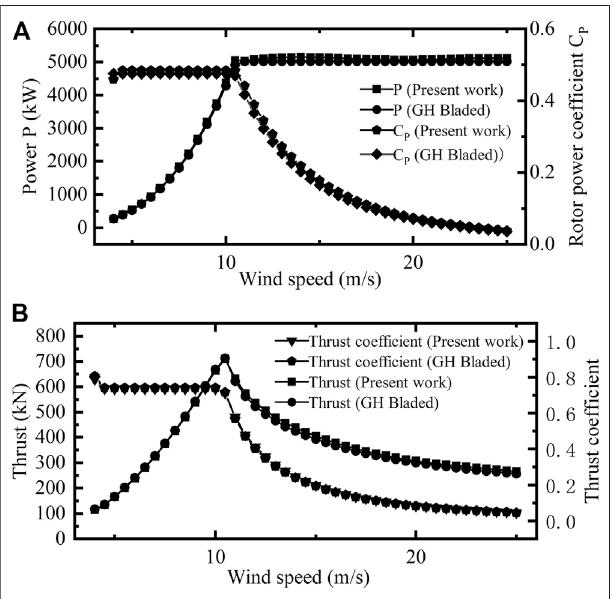
FIGURE 6 | The aerodynamic characteristics of the rotor under the operatingwindspeed. (A) Rotorpowerandrotorpowercoef fi cientcurves. (B) Thrust and thrust coef fi cient